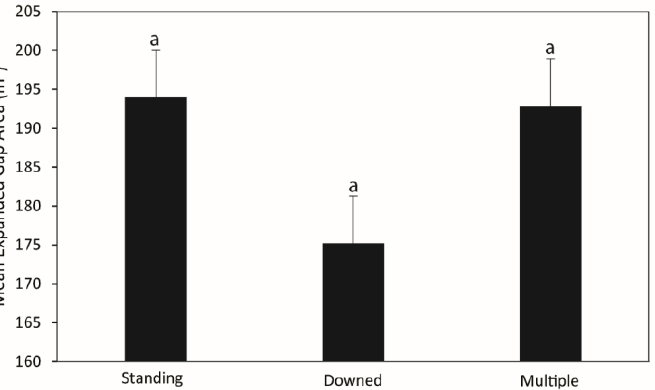
Figure 1. Mean expanded gap area for canopy gaps formed by single standing trees (snags), single downed (snapped and uprooted) trees, and multi-tree gaps in a montane Pinus palustris woodland. Different letters indicate a significant ( p < 0.05) difference between categories.